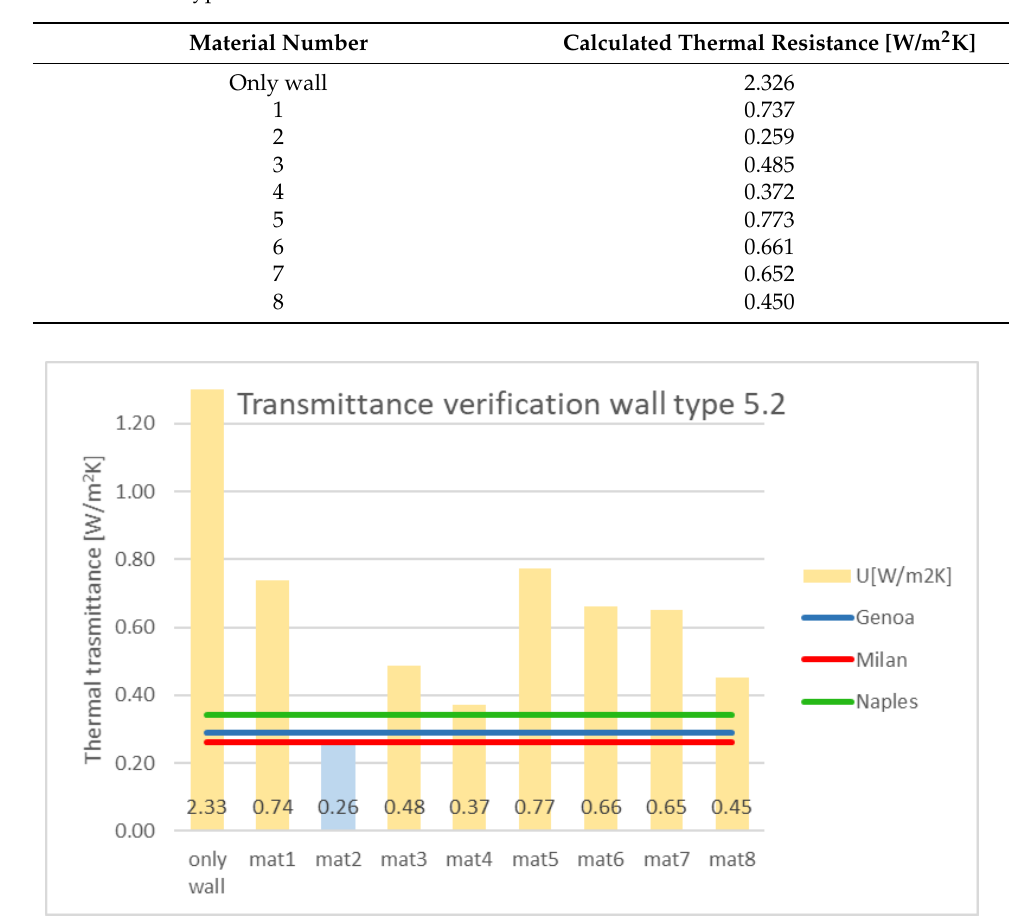
Figure A16. Wall type 5.2: transmittance check for the three main Italian climatic zones. In are blue the heat-reflective materials which respect all the limits.